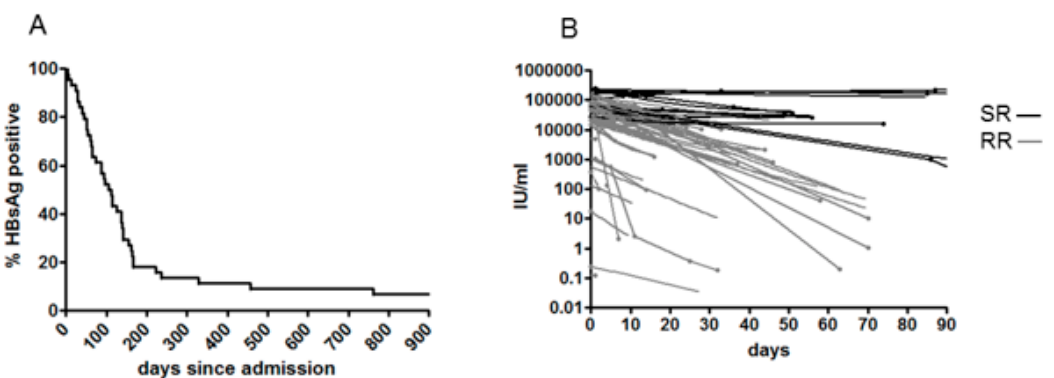
Figure 2. HBsAg clearance in acute symptomatic hepatitis B. Kaplan Meier analysis of HBsAg clearance ( A ) and individual decay curves of HBsAg ( B ) in Rapid Resolvers (RR) (grey) and Slow Resolvers (SR) (black) patients.